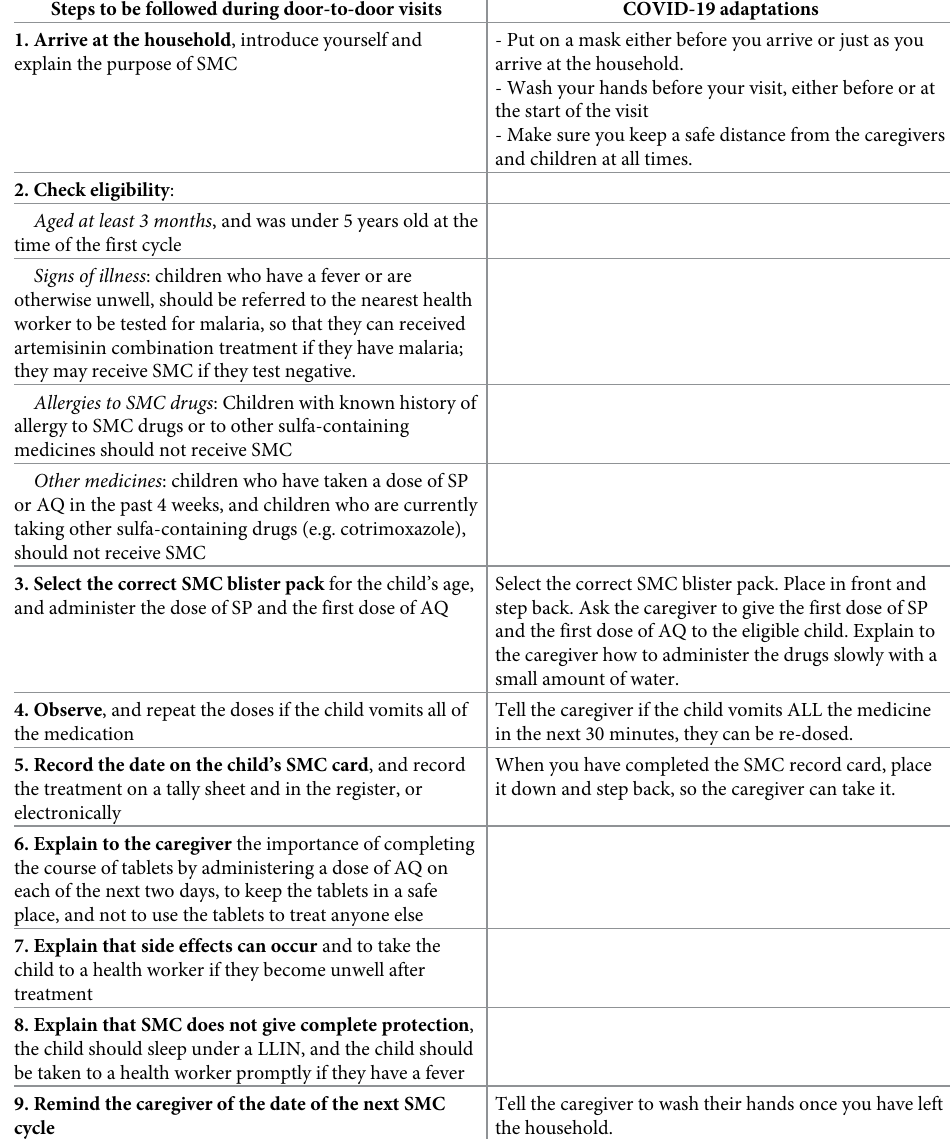
ted via phone apps such as WhatsApp or Bluetooth. Table 1. Steps involved in SMC delivery, and adaptions made in the context of COVID-19, described in the video job-aid. Steps to be followed during door-to-door visits COVID-19